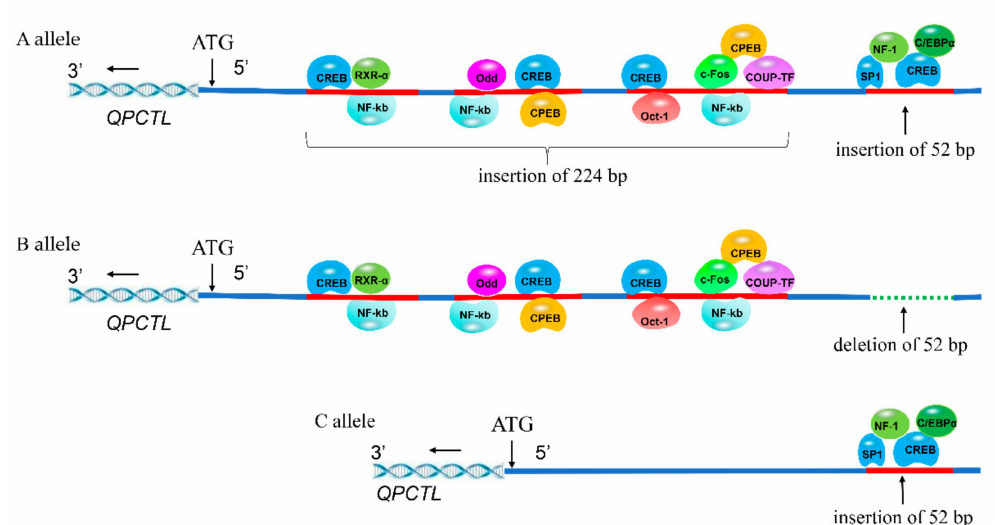
Figure 4. Predicted binding sites of transcription factors in the A, B and C alleles; the A allele (insertions of 52 bp and 224 bp), the B allele (deletion of 52 bp and insertion of 224 bp) and the C allele (insertion of 52 bp). The − 362 to − 89 (ATG as +1) region existed in three Indels: 112 bp, 96